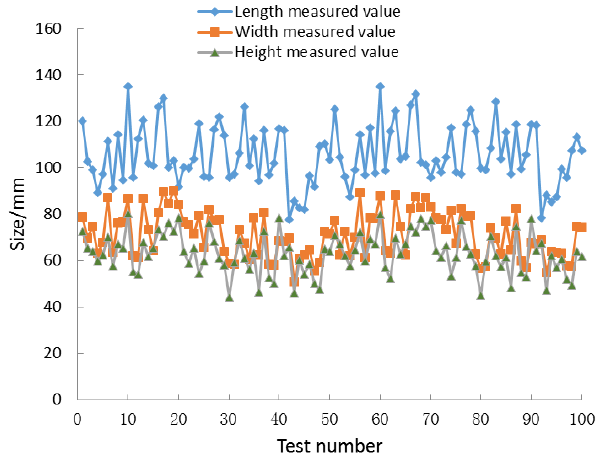
Figure 10. Three-dimensional size of potato tubers.